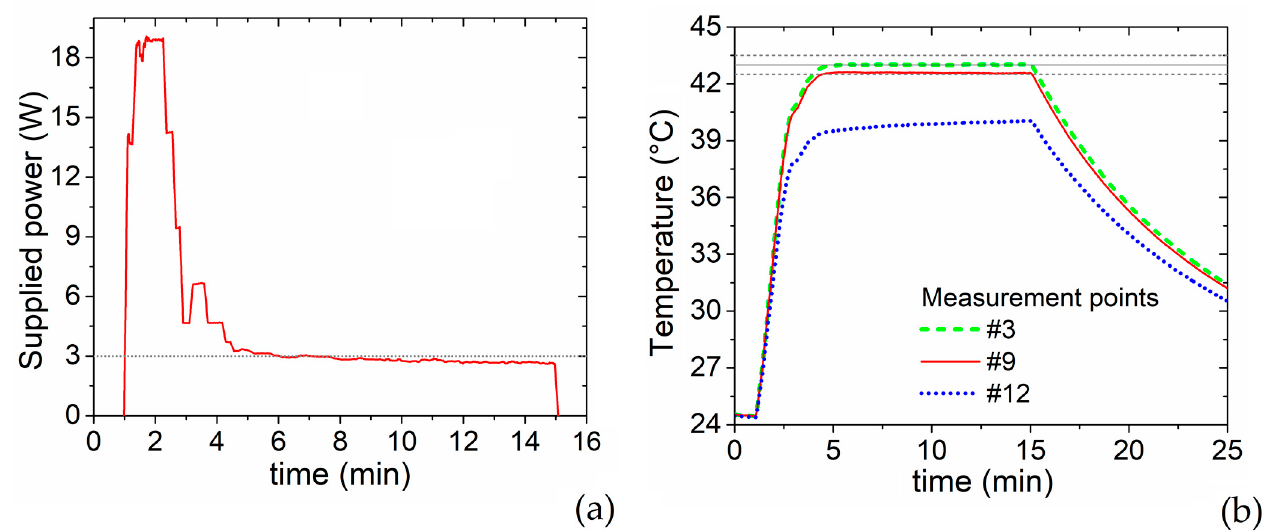
Figure 6. ( a ) Time evolution of the power effectively supplied to the RF applicator to perform steady-state measurements at 43 ° C. ( b ) Consequent heating-cooling transients, measured in points #3, #9 and #12. The target temperature of 43 °C is indicated with a solid dark grey line, while the dashed lines indicate a ± 0.5 °C difference from the target temperature.